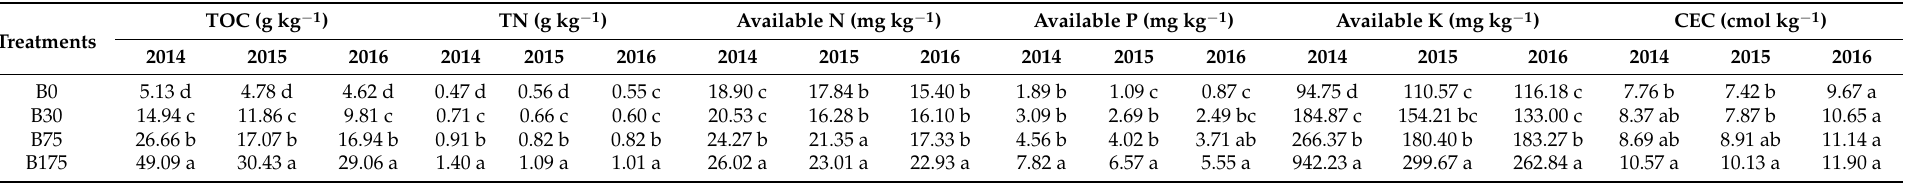
Different letters in the same column indicate the significant difference between different treatments ( p < 0.05). Table 4. Contents of total organic carbon (TOC), total nitrogen (TN), available nitrogen (N), phosphorous (P), potassium (K), and cation exchange capacity (CEC) in sulfate saline soils amended with biochar at various rates from 2014 to 2016.